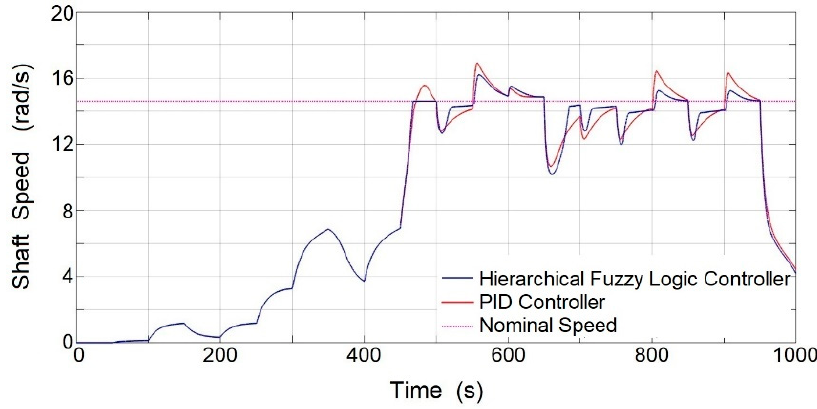
Figure 17. Rotation speed of generator shaft. Differences in performance between the HFLC and the PID controller are observed. The HFLC shows better performance as, in operating region III, it greatly reduces the error in the speed of the rotor shaft with respect to nominal speed.